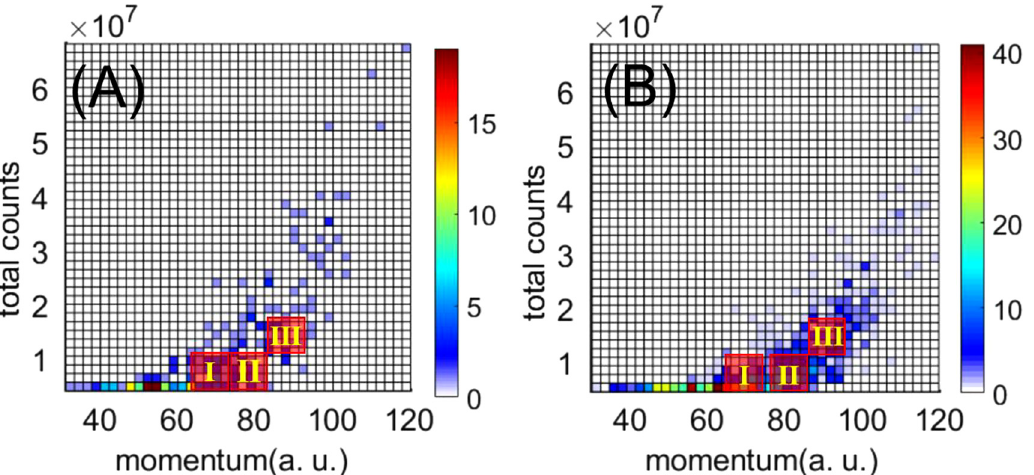
Figure 6: (A – C) show the integrated (the first column) and the single-shot (the 2nd to the 5th column) H + momentum distributions at three laser intensities at 400 nm. The three intensity regions correspond to the areas marked by I, II, and III in Figure 7(A). (D – F) Similar to (A – C) but obtained at 800 nm. Theblackandredarrowsatthebottomright of the fi gure indicate the laser propagation and polarization directions, respectively.